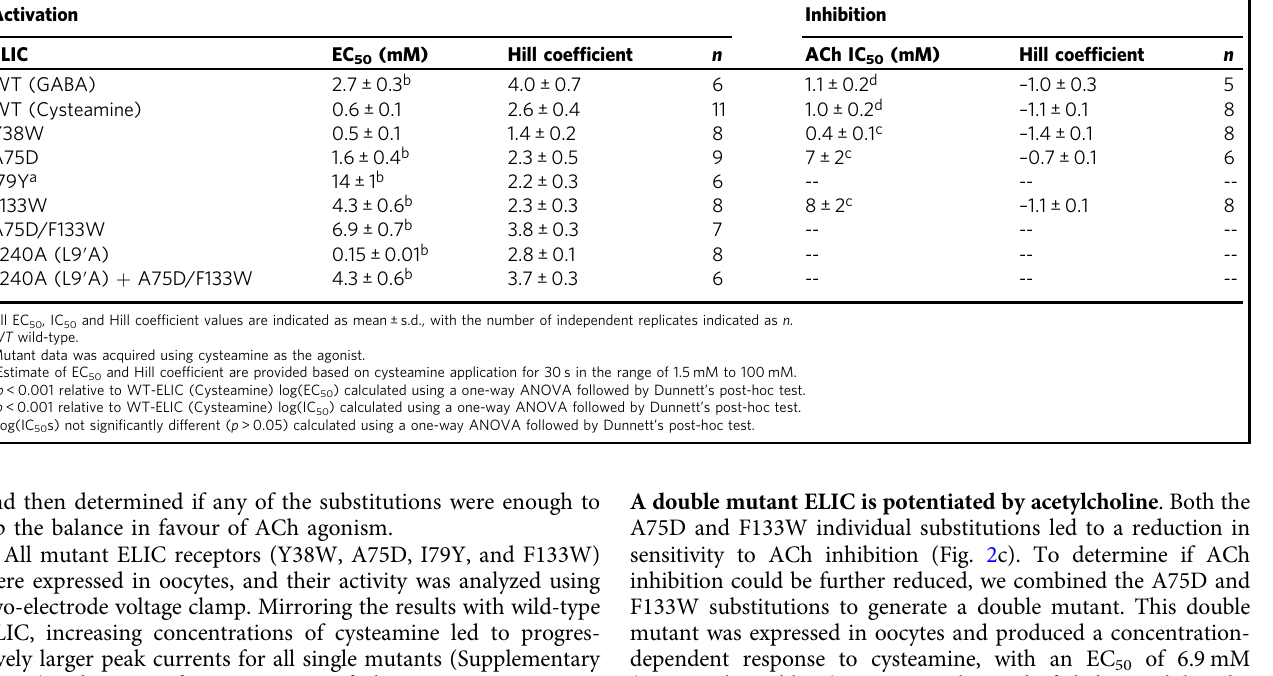
Table 1 Activation and inhibition parameters for wild-type ELIC and its variants.